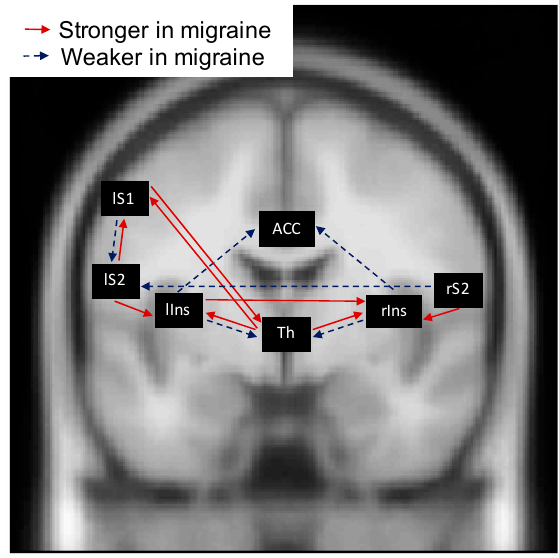
Figure 3. Parametric empirical Bayes results on the connectivity strengths in the first block as estimated with dynamic causal modelling. Only parameters with a posterior probability of being different from zero >0.99 are visualized. Red arrows (solid arrows) indicate that the connectivity strength is stronger in the migraine group, while blue arrows (dashed arrows) indicate that the connectivity strength is weaker in the migraine group. For precise differences between groups, see main text.